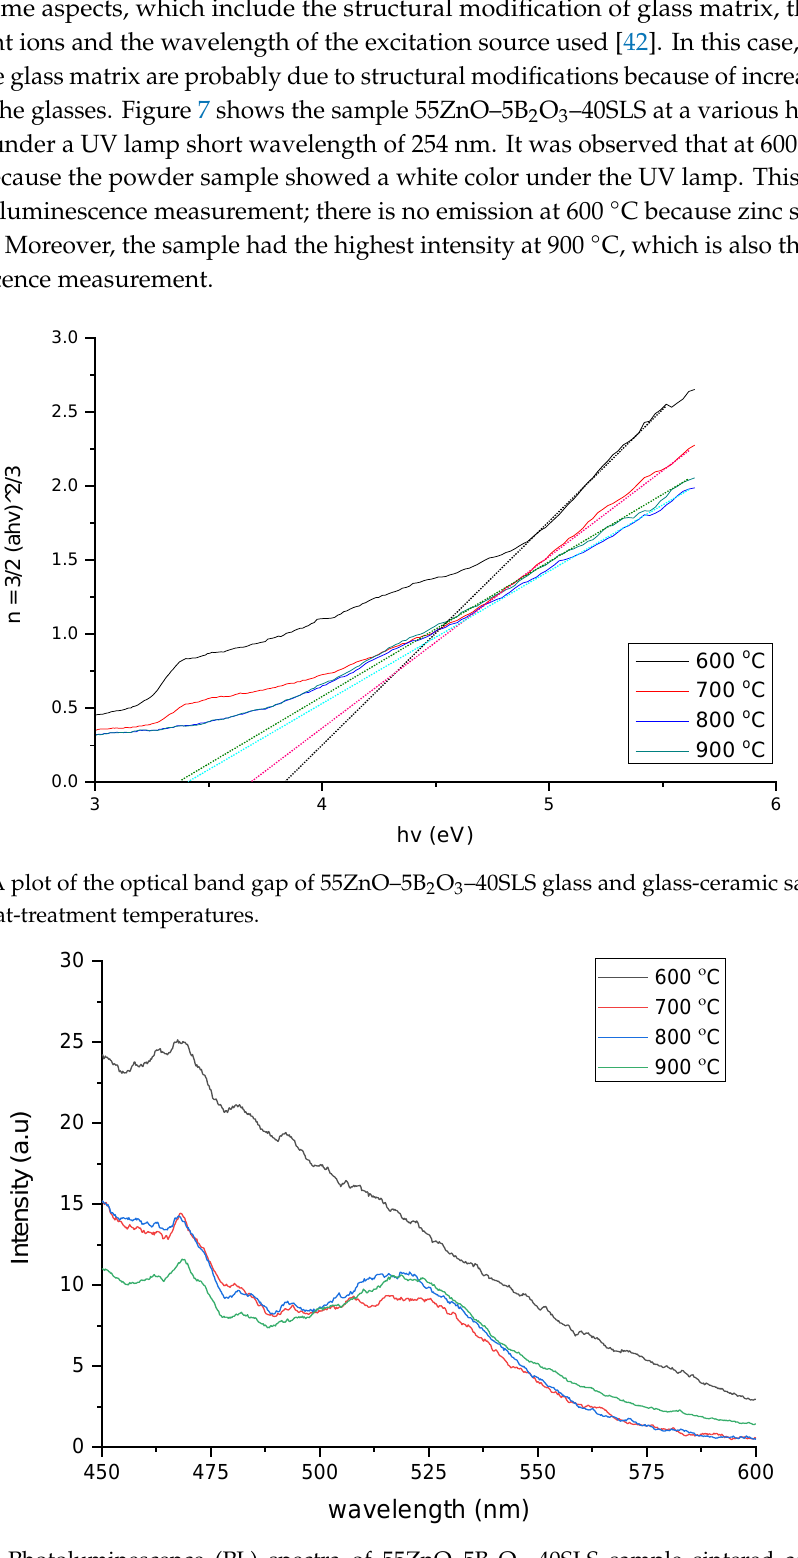
Figure 7. Sample of 55ZnO–5B 2 O 3 –40SLS treated at a various heat-treatment temperatures under ultraviolet–visible (UV) lamp of 254 nm. 4. Conclusions The phase transformation, optical and luminescence performance of new zinc silicate derived from the ZnO–B 2 O 3 –SLS glass system was successfully investigated. The result shows that the density and linear shrinkage of the sample increased with the progression of heating temperature. In addition, the XRD characterization shows that the samples start with an amorphous glassy state at 600 °C, but when sintered at 700, 800 and 900 °C, the samples show a sharp peak indicating presence of the crystal inside the samples. The IR spectrum of FTIR shows the presence of structurally associated SiO 4 and ZnO 4 , which indicate the formation of a zinc silicate crystal phase. The optical band gap decreased due to short-wavelength light being scattered by the zinc silicate crystal as the crystallinity increased at higher heat-treatment temperature. Lastly, photoluminescence spectra excited at 254 nm resulted in emission spectrum emitted with a green color at 524 nm. Based on this research, ZnO reacts as network modifier or former because it is an intermediate oxide corresponding to the mixture of the glass matrix, and behaves to alter the structural glass system. Finally, B 2 O 3 works as one of the most important glass formers and flux materials, which forms a connected backbone glass network.